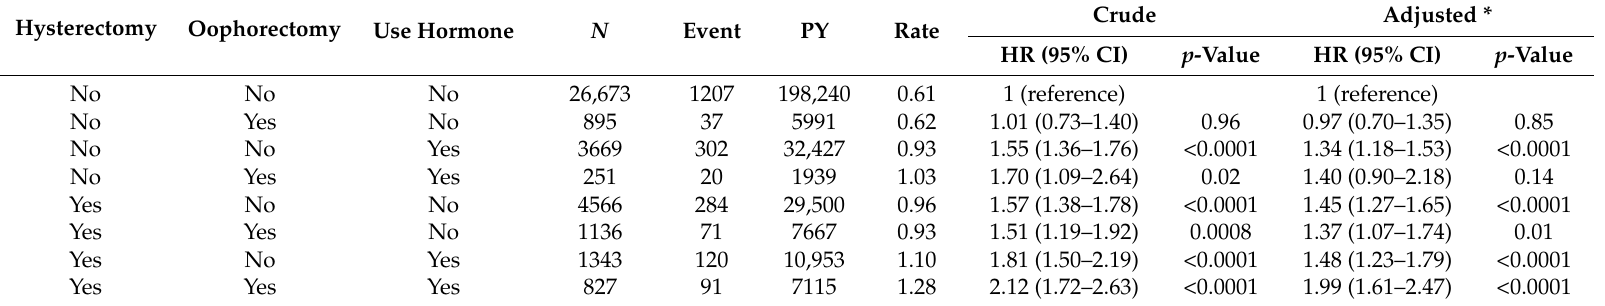
Table 5. Risk of depression in women underwent hysterectomy, oophorectomy, and hormone